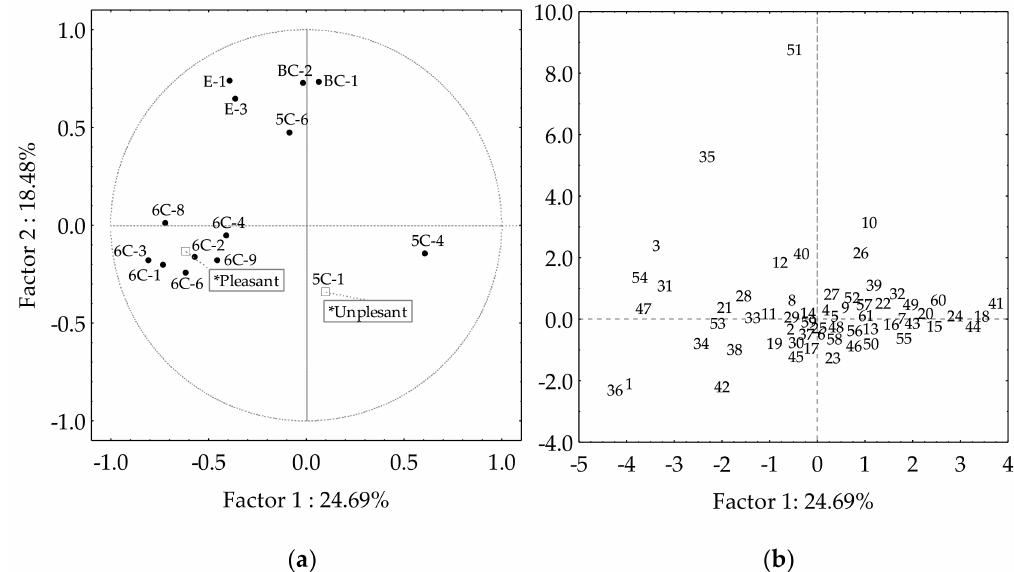
Figure 4. Selected volatile compound contributors to the aroma (OAV > 1) of the oils from the WOGC cultivar subset. ( a ) Vector distribution of the selected volatiles. ( b ) Distribution of the